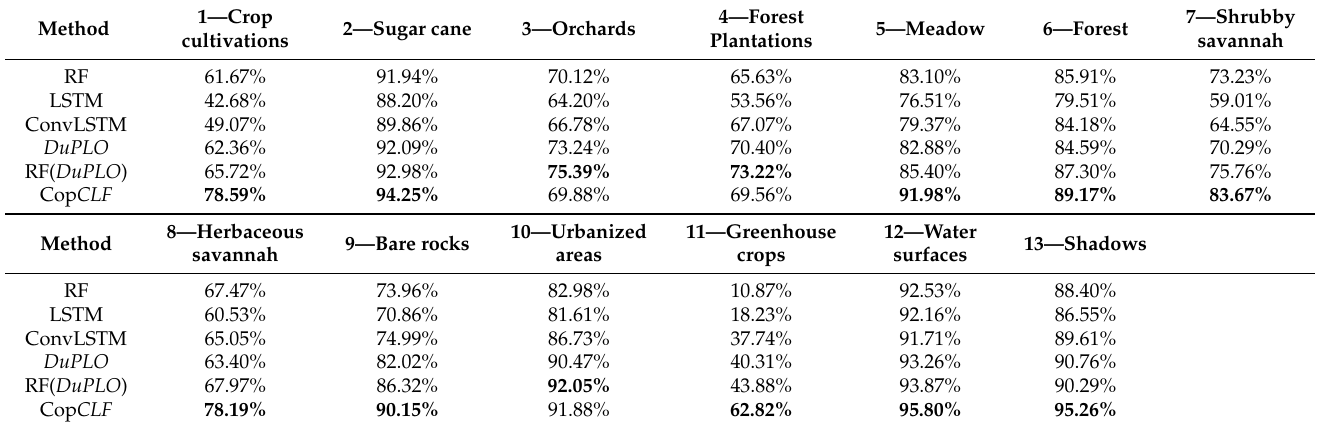
Table 2. F-Measure per class for the Reunion Island dataset. (Best result for each class in bold).